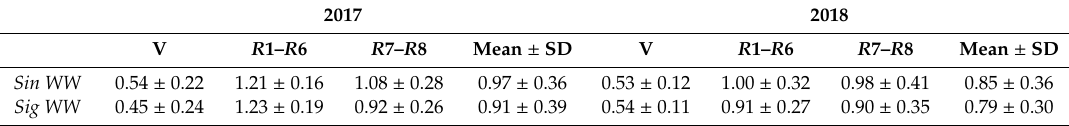
Table 4. The monthly mean crop coefficient ( K c ) for three developmental stages (V: vegetative growth; R 1– R 6: from the start of bloom to full seed; R 7– R 8: from the start of maturity to full maturity) based on Fehr and Caviness (1977) [27]. Abbreviations: Sinara : Sin ; Sigalia : Sig ; WW : no limited water supply.